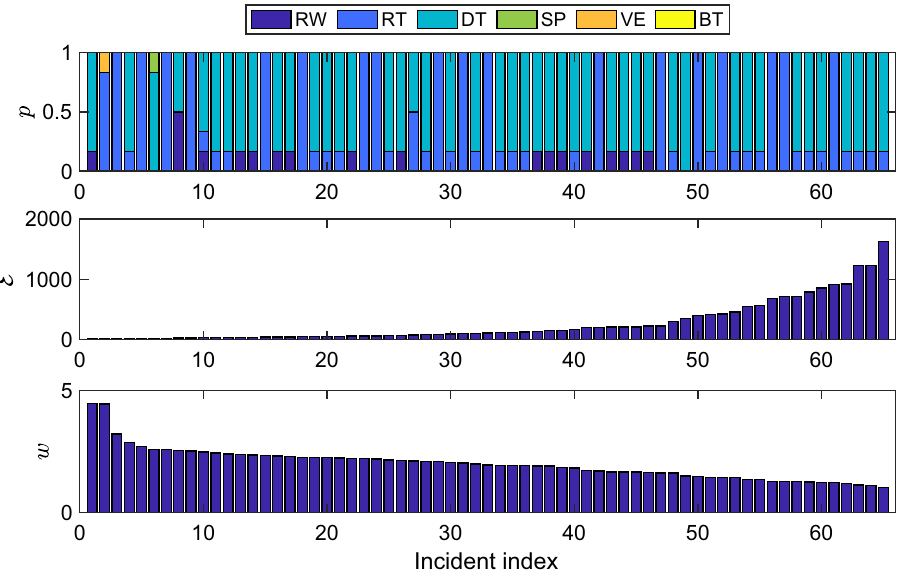
Figure 4. Results from model simulations and fitting. The behavioral profile p (top), energy statistic E (middle), and weight w (bottom) for all N = 65 incidents sorted from highest to lowest